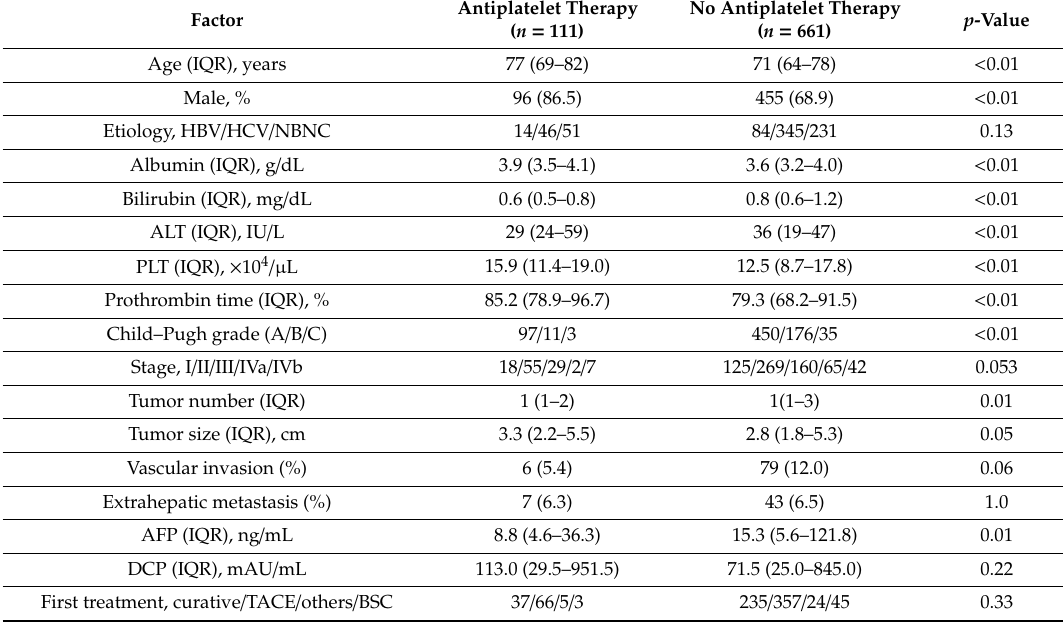
Table 1. Baseline characteristics in hepatocellular carcinoma (HCC) patients undertaking or not undertaking antiplatelet